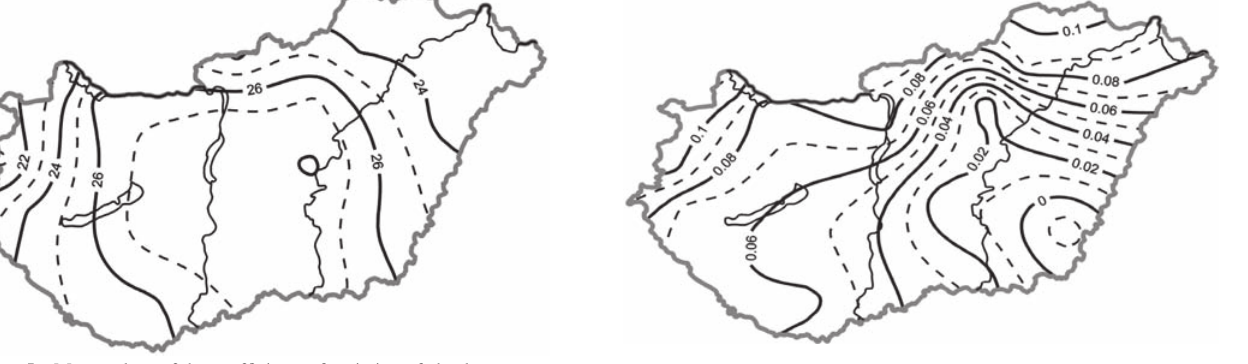
Figure 7 – The spatial distribution of slopes of the trendfunction of absolute temperature minima in spring measured at 16 stations over a period of 1951–2010